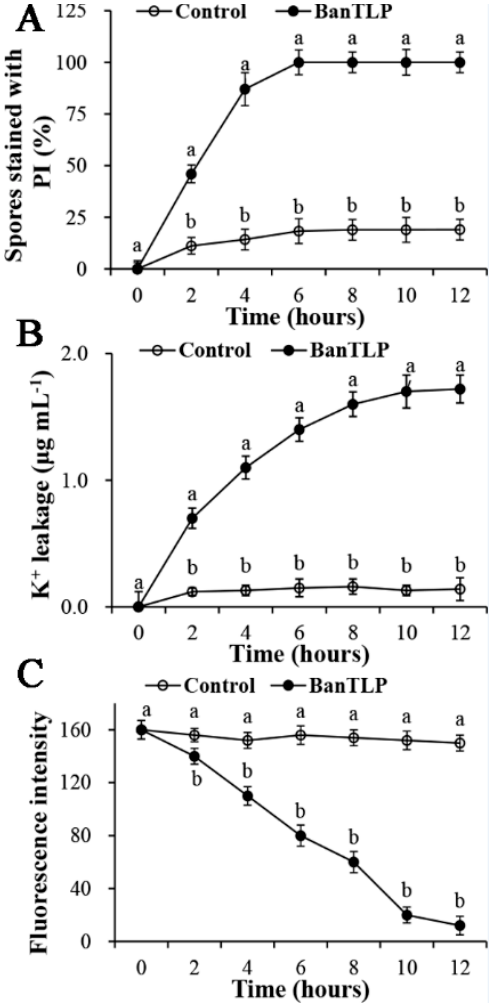
Figure 3. Effects of BanTLP at 60 μ M on the plasma membrane of P. expansum conidia as the exposure times extended. ( A ) Spores stained with propidium iodide (PI); ( B ) the leakage of intracellular potassium ions; ( C ) 1,6-diphenyl-1,3,5-hexatriene (DPH) fluorescence intensity of P. expansum. Each value is mean of three replicates for two independent experiments. Vertical bars represent standard deviations of means. Those data marked with different letters are significantly different ( p < 0.05) between control and treatment groups at the same time according to Duncan’s multiple range